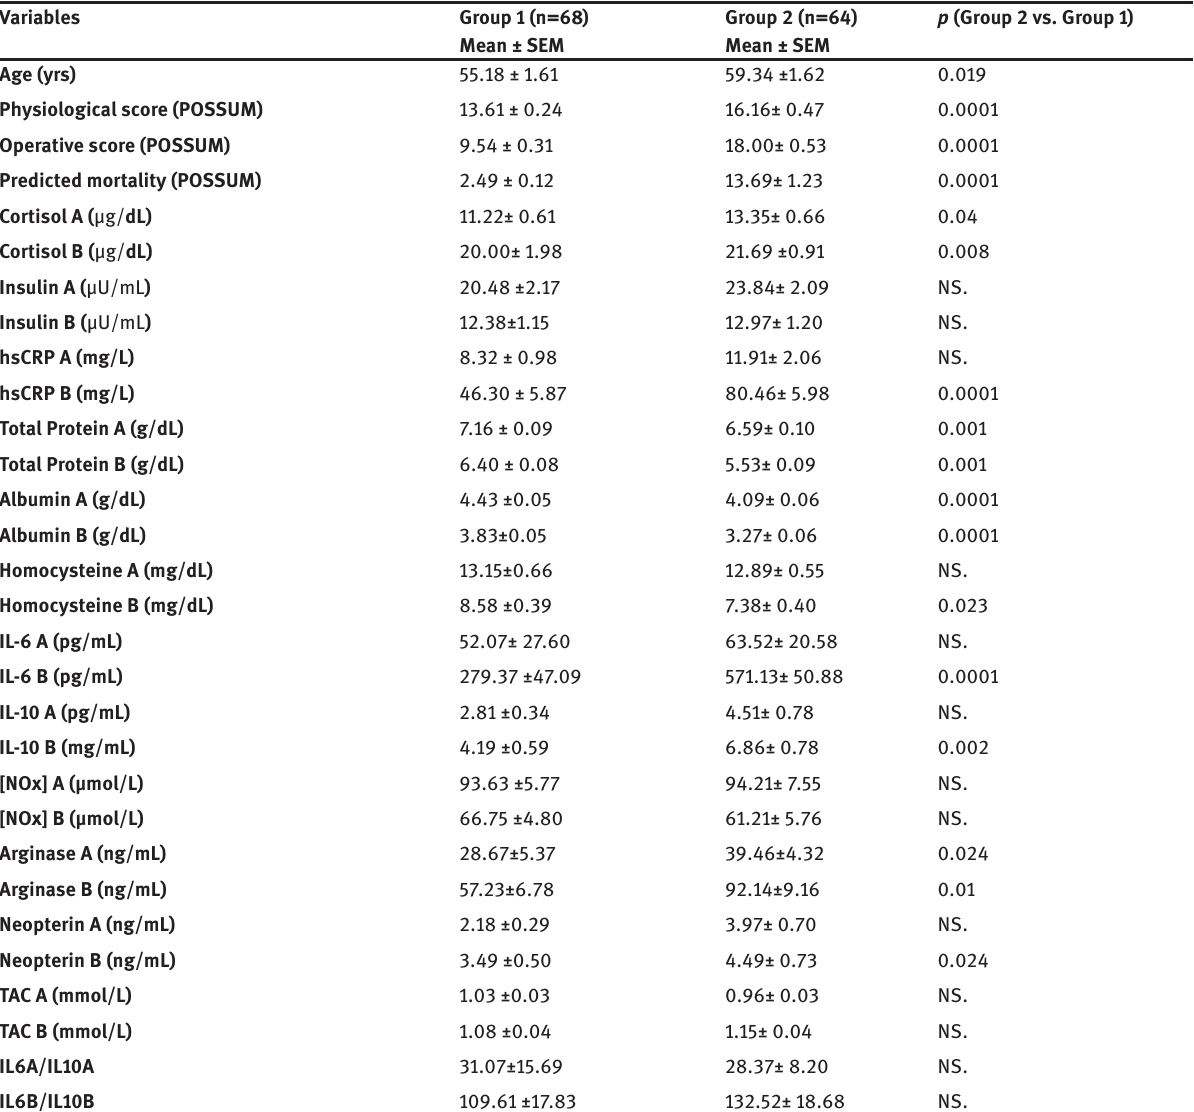
Table 2: One hundred and thirty-two patients were scored using POSSUM morbidity and mortality risk evaluation system and they were allocated to one of the two risk groups during the first 24-hour of post-operative period: Group 1; POSSUM predicted mortality rate was lower than 5 % and Group 2; POSSUM predicted mortality rate was higher than 5 %. The statistical evaluation of 26 additional variables were made between two groups. (A: Pre-operative value; B: post-operative value; hsCRP: high sensitivity C-reactive protein; IL- 6: interleukin-6; IL-10: interleukin-10; NOx: plasma nitrite + nitrate; TAC: serum total antioxidant capacity; SEM: standard error of